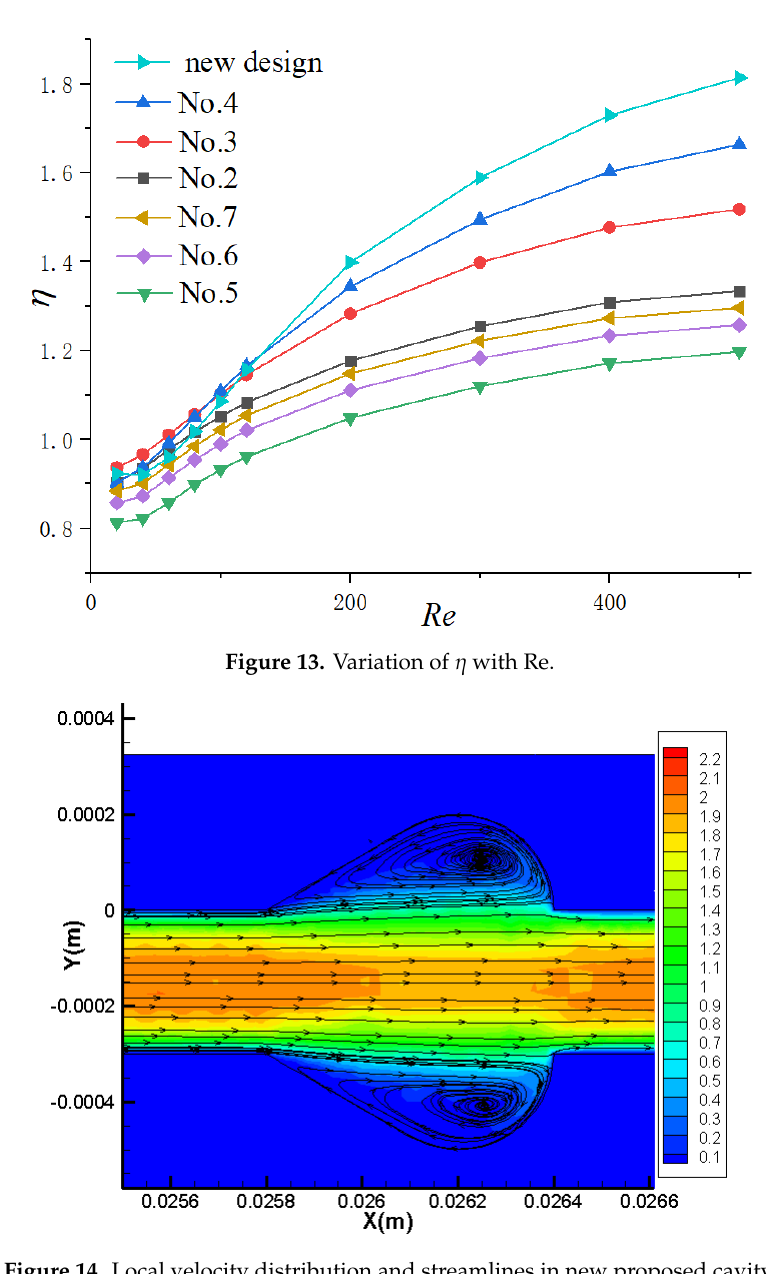
Figure 14. Local velocity distribution and streamlines in new proposed cavity.